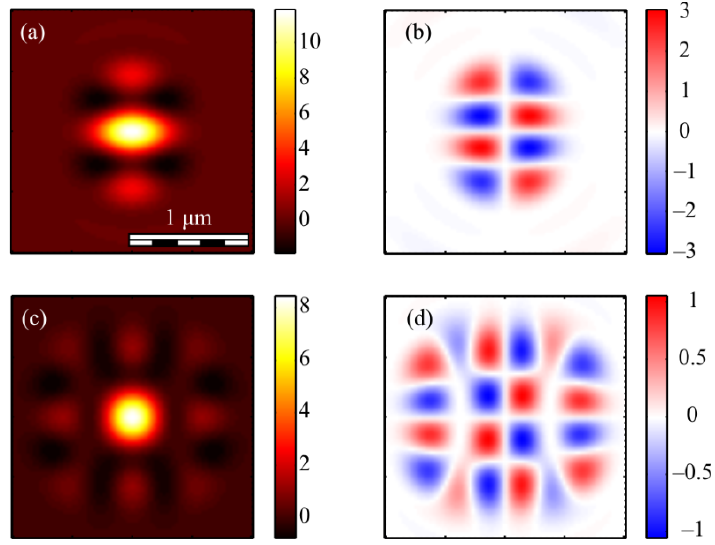
Figure 9. The Stokes vector components s 1 ( a , c ) and s 2 ( b , d ) of the focused vector field (1) with m = 2 (a, b) and m = 4 (c, d) for a = 1.